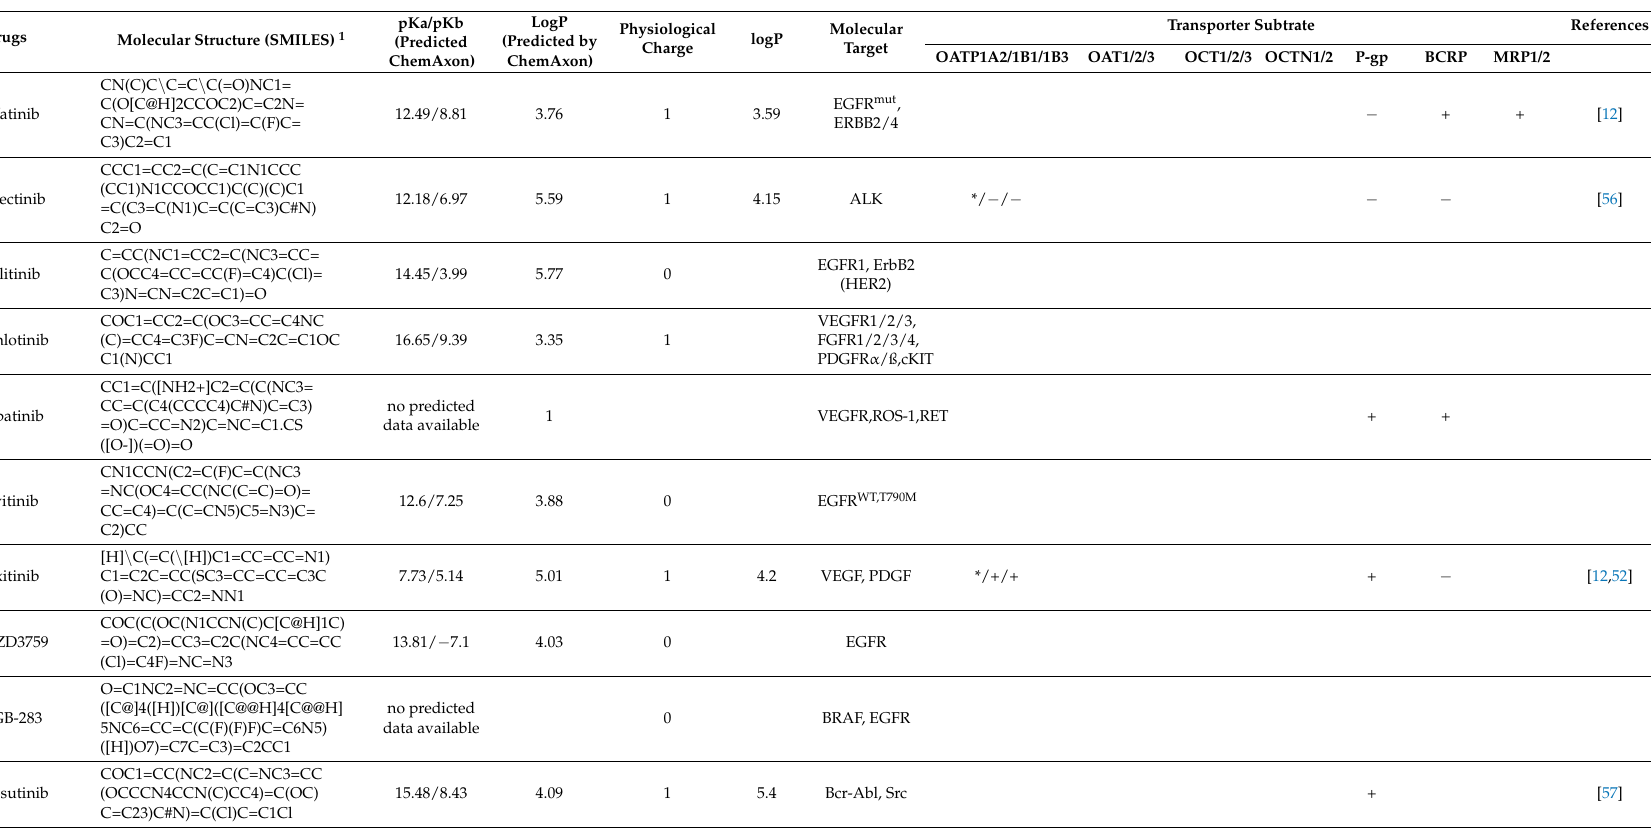
Table 1. Overview of approved TKIs and several promising TKIs at various stages in development. Their molecular structure, physicochemical properties and molecular target, as well as their interaction with various influx and efflux transporters are shown. A (1) or (0) indicates whether or not a TKI is likely to be charged in an aqueous solution. The note (+) indicates a TKI is a substrate, ( − ) indicates that the TKI is confirmed not a substrate, and (*) or a blank spot indicates that there is no data available on the interaction between respective TKI and